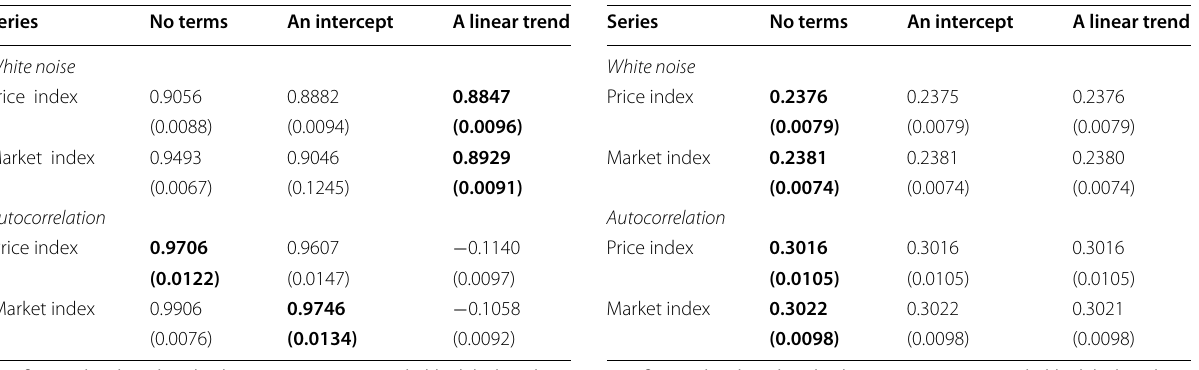
Table 3 Estimates of d for the fully sampled logged series Table 4 Estimates of d for the fully sampled volatility